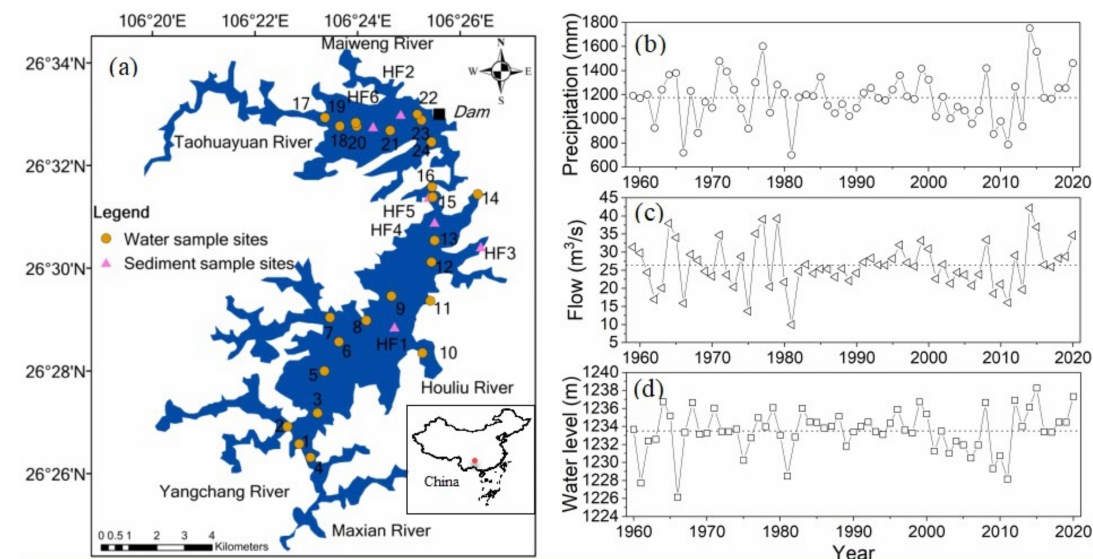
Figure 1. Water and sediment sampling sites of Hongfeng Lake ( a ), the red point represents the location of the reservoir in China map, precipitation ( b ), flow ( c ), and water level ( d ) from 1959 to 2020. The dotted line represented the average value in ( b – d